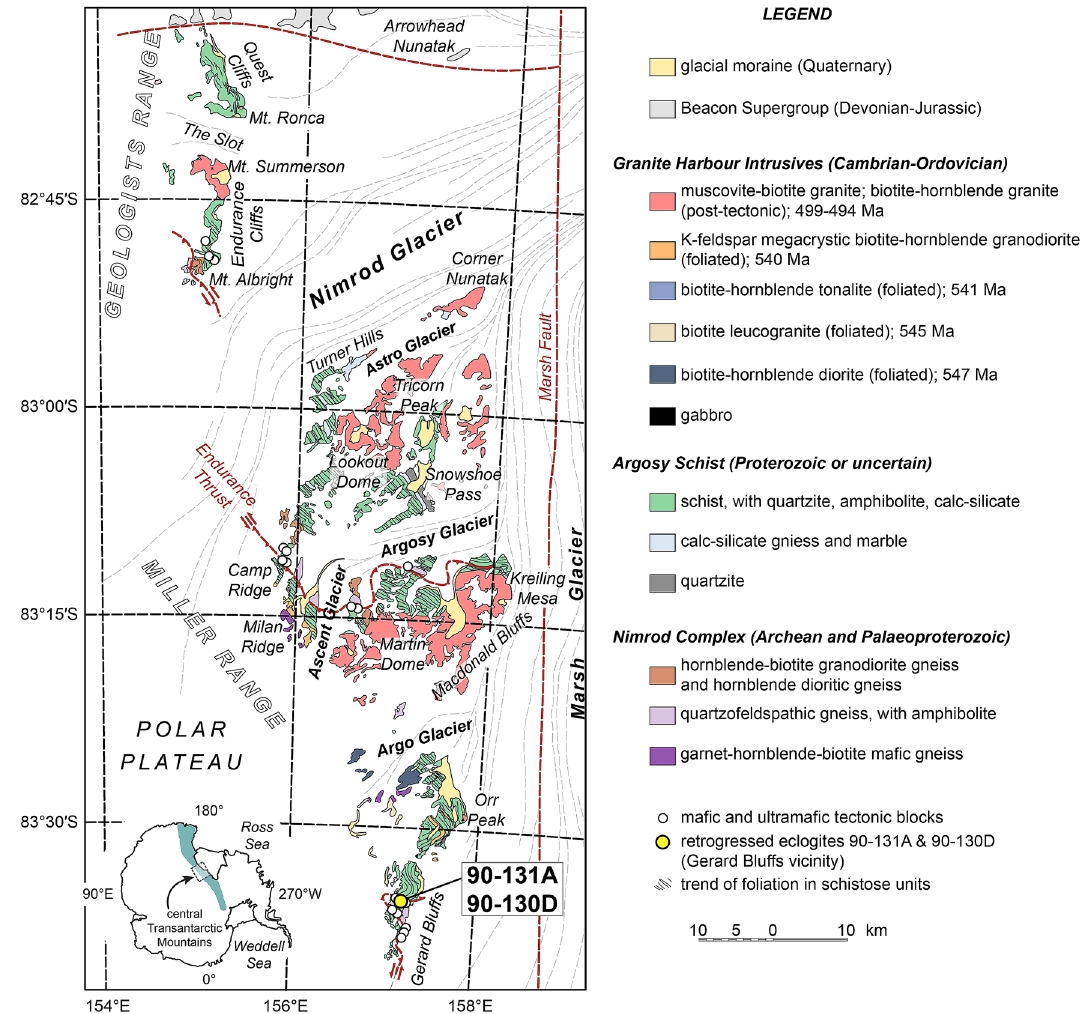
(83°35 ′ 23 ″ S; 157°10 ′ E). Figure modified from Goodge and Fanning 23 using Adobe Illustrator 22 . Note that